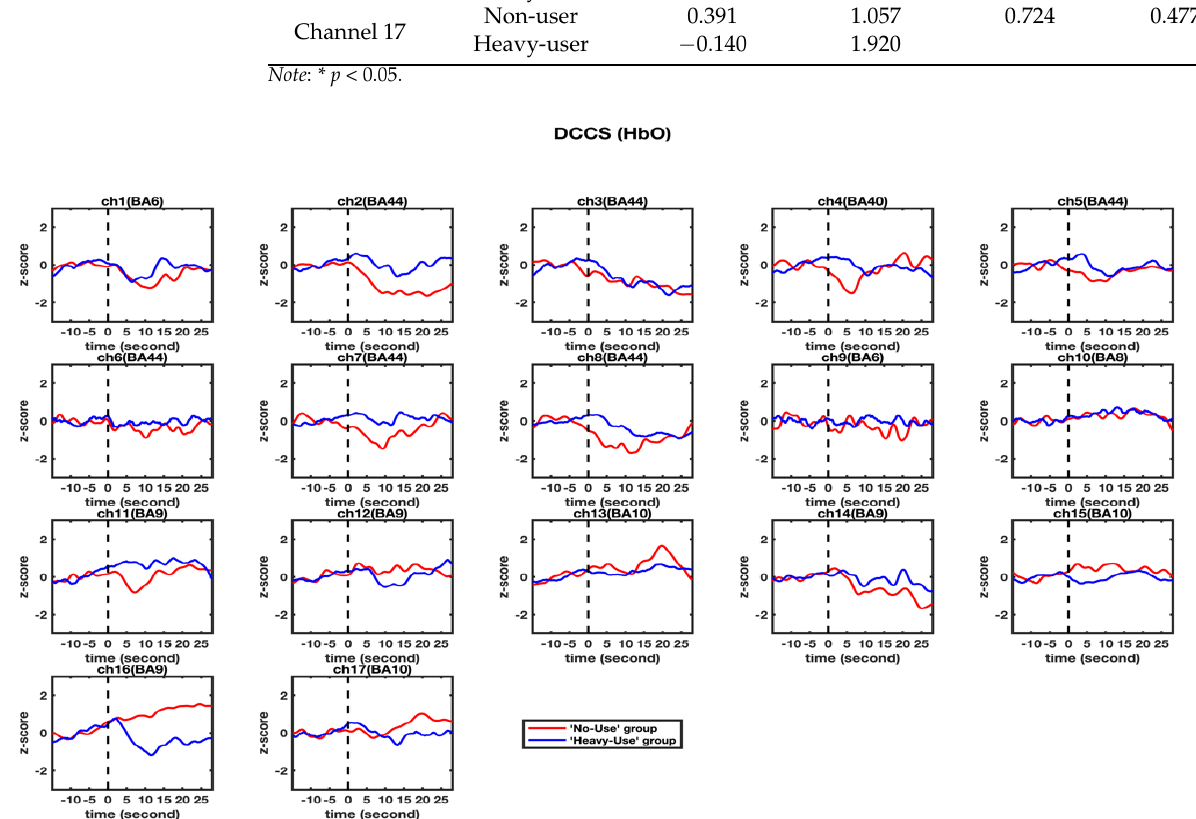
Figure 4. Observed changes in the HbO concentration in the 17 channels during the DCCS tasks. The HbO data for the ‘non-user’ and ‘heavy-user’ group are shown in red and blue line, respectively.